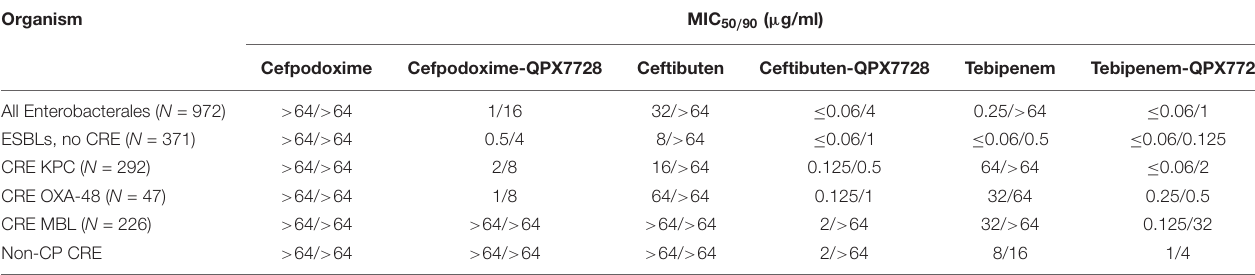
TABLE 8 | In vitro activity of QPX7728 in combination with oral β -lactams against Enterobacterales producing ESBLs and carbapenemases. Organism MIC 50 / 90 ( µ